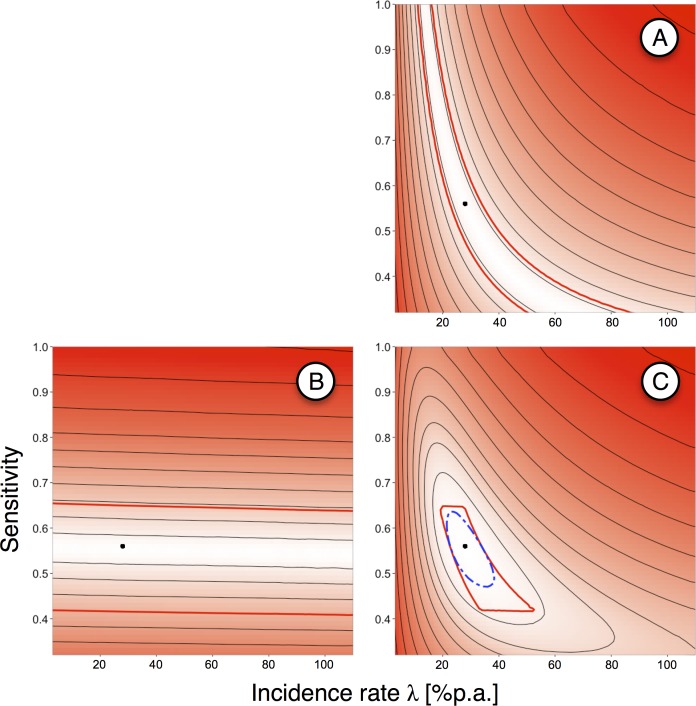
Incidence rate vs. sensitivity, maximum-likelihood estimate and plausible parameter range, Ugandan sex workers.(A) Initial prevalence. (B) continuously M. genitalium-positive participants over time. (C) Both data items combined. Thick, black dot: maximum-likelihood estimate (MLE) for the incidence rate (λlow = 28%p.a.) and sensitivity (56%) with recovery rate fixed at γ = 0.80p.a. (from London-student data); thin, black contours: equal likelihood; colored areas: white indicates maximum likelihood, red indicated low likelihood; thick, dashed, blue contour: 95% CI of the MLE; thick, red contour: parameter areas where the model is consistent with the empirical data (α<0.05).